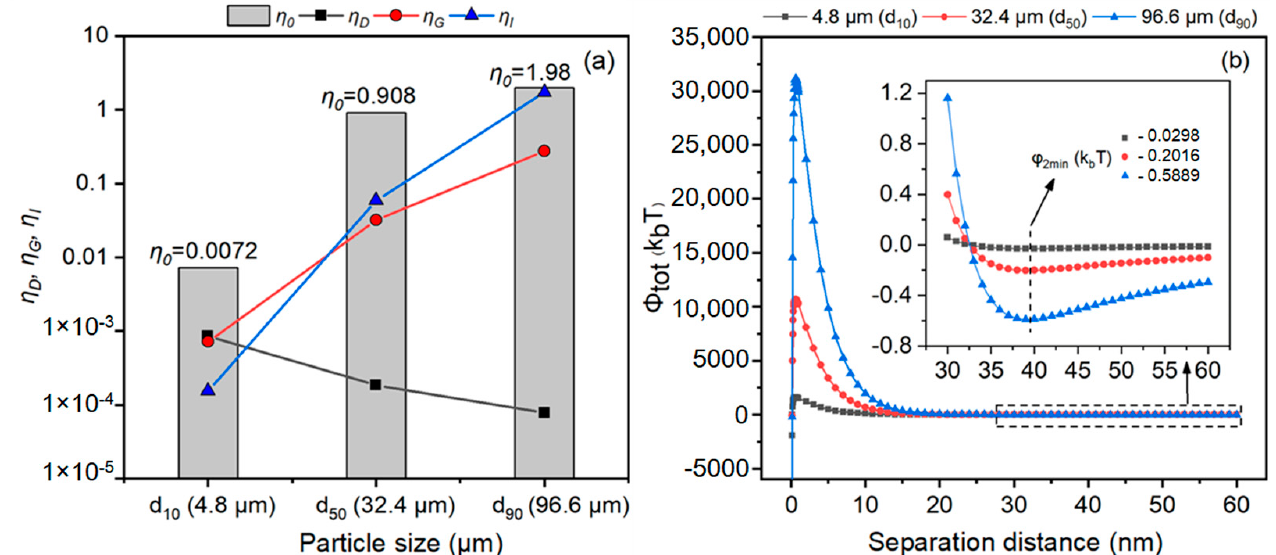
Figure 4. Change in contact efficiencies with size distributions of d 10 , d 50 , and d 9 ( a ); change represented as free energy and second energy minimum on the surface of suspended particles and sand ( b ).